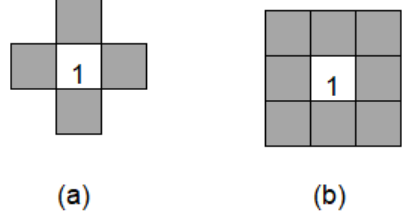
Figure 1.a. The Von Neumann neighbor of cell ‘ 1 ’ ; Figure 1b: